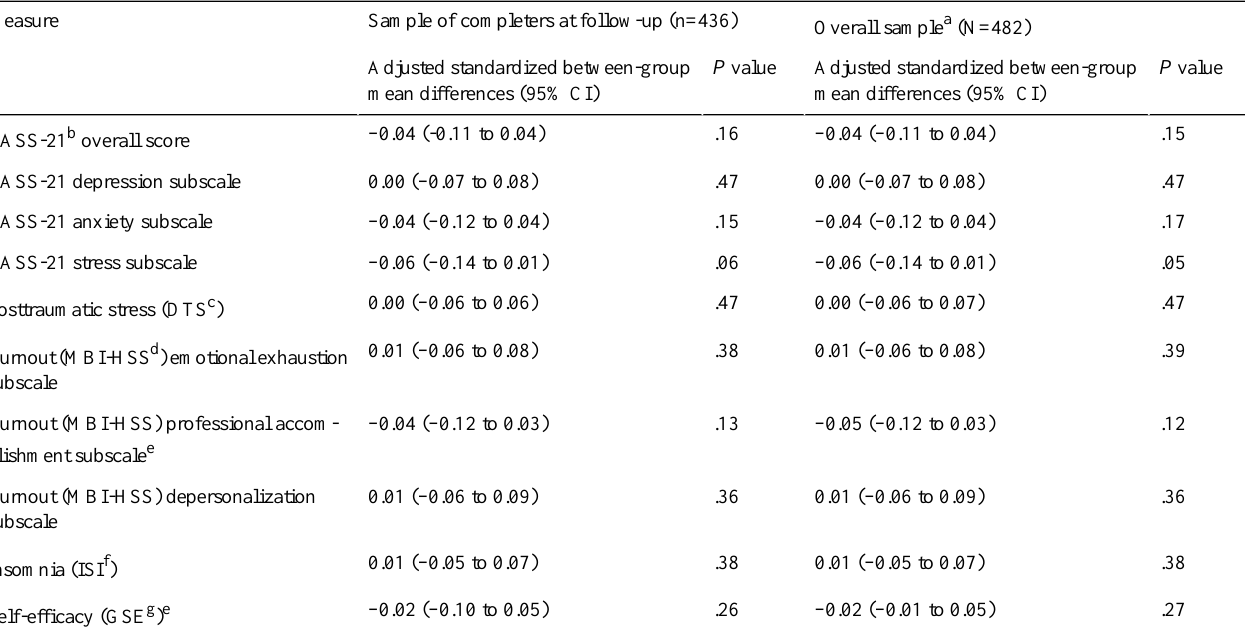
Table 4. Comparison of outcome measures between the PsyCovidApp and the Control App groups at 2 weeks. Data are adjusted standardized between-group mean differences with 95% CIs in parentheses. P values are not adjusted for multiple